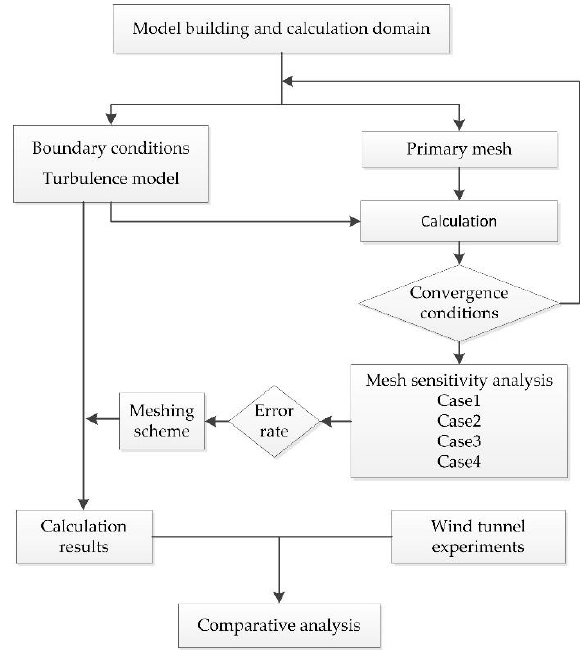
Figure 1. Flowchart of this research work.